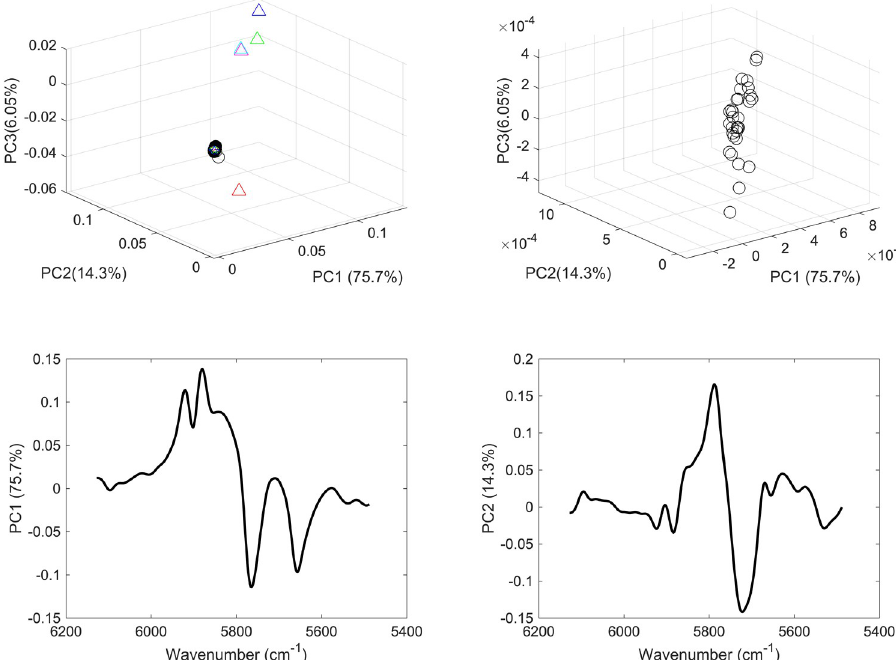
Fig 6. (a) PCA scores plot of COVID-19 vaccine (black circles), mRNA (red star), purified RNA (green and blue stars), normal saline solution (red and green squares) and excipients 1–5 (blue, red, green, cyan and magenta triangles); (b) PCA scores plot of COVID 19 vaccines; (c) PCA loading plot of vaccines and constituents and (d) PCA loading plot of vaccines. The models were applied considering the wavenumber range of 5488–6128 cm -1 .